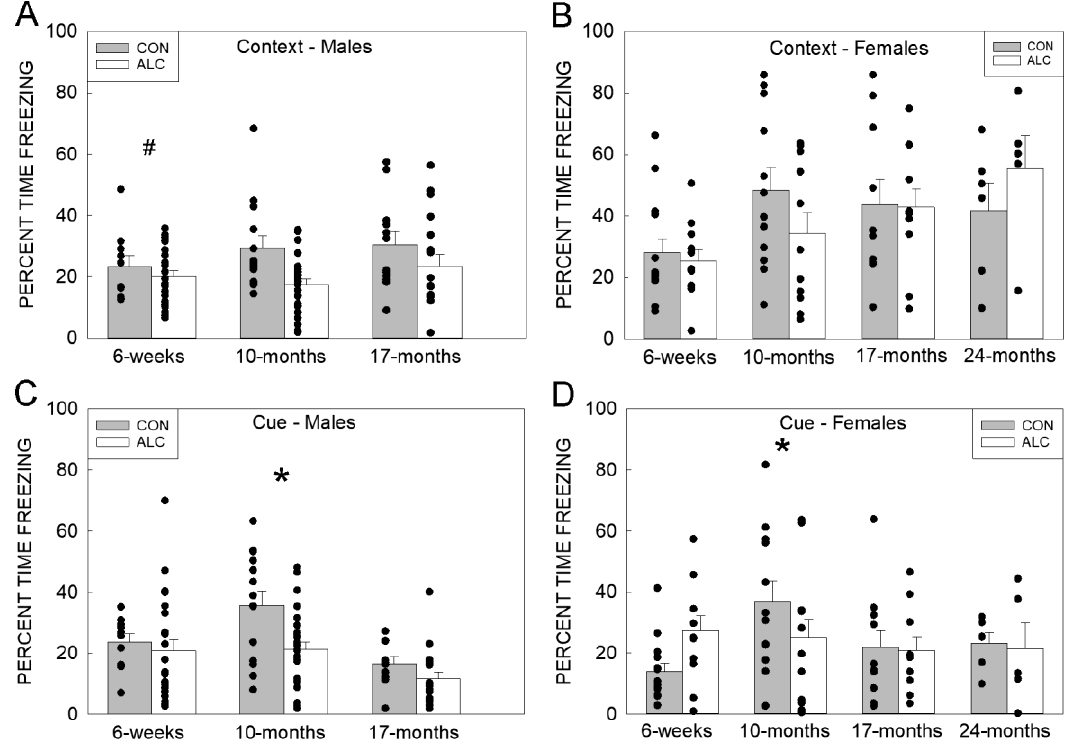
Figure 5. ALC and CON performance in the contextual and cued fear conditioning task. ( A , B ) Percent time freezing does not differ in ALC and CON males ( A ) or females ( B ) in the contextual learning task. There is less freezing in males at 6 weeks versus older ages. ( C , D ) Percent time freezing is reduced in ALC males at 10 months ( C ) and in ALC females at 10 months ( D ) compared with age-matched CON in the cued learning task. Values are mean ± SEM, dots represent values for individual animals. The number of animals tested in each group is presented in Supplemental Table S1. * Indicates ALC differs from CON at p ≤ 0.05. # Indicates that 6 weeks differs from older ages at p < 0.05.